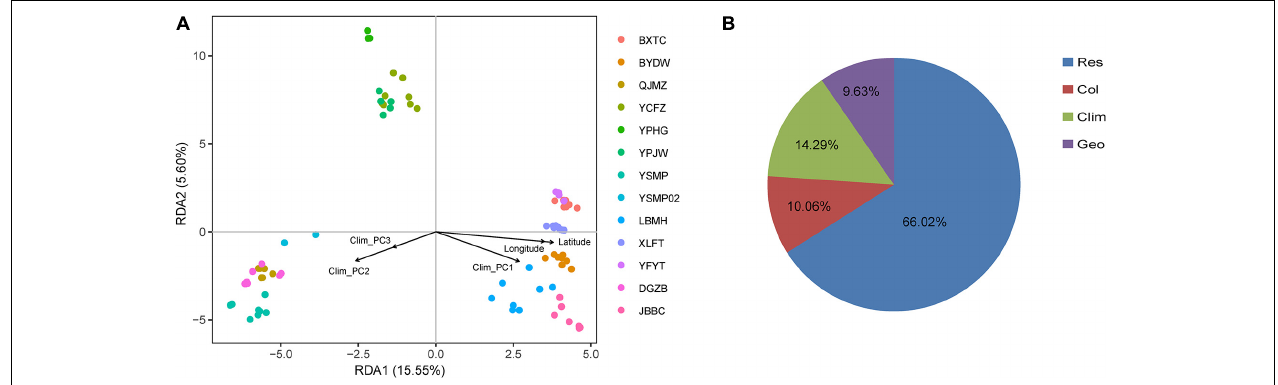
FIGURE 5 | Redundancy analysis (RDA) performed with 24,225 SNPs among 87 samples. (A) The first two axes shown for RDA, using latitude, longitude, and climate as constraining variables. Colored points represent samples from different populations. (B) Proportion of total SNP variation explained in RDA by climatic variable (Clim), spatial structure (Geo) or their collinear effect (Col), respectively. The residential variation (Res) was